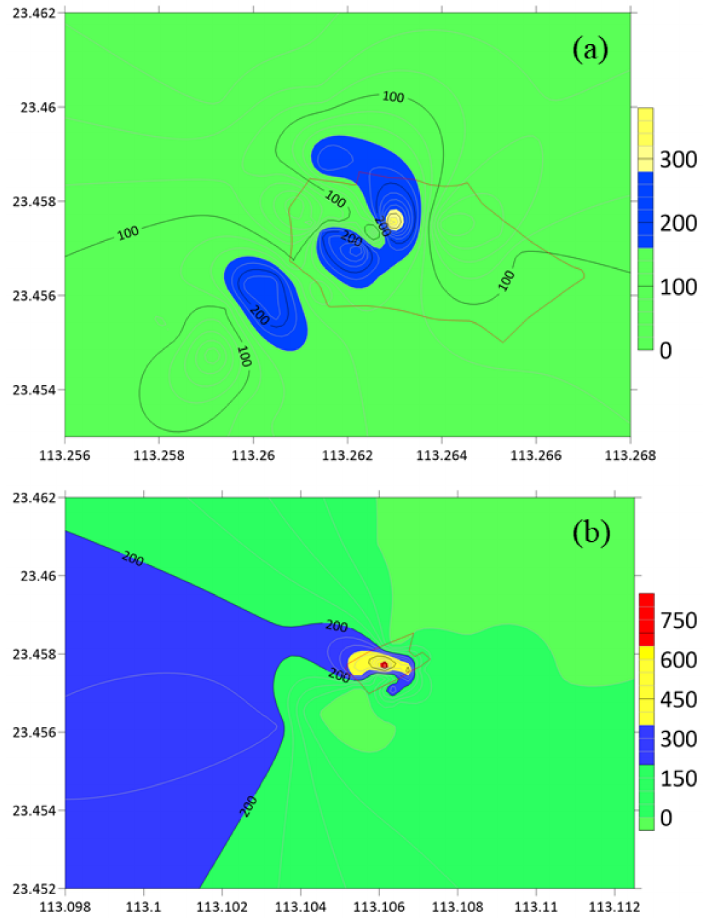
Figure 8. Spatial distribution of risk index ( RI ) of heavy metals from ( a ) Factory A, ( b ) Factory